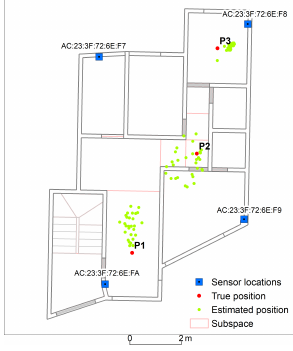
Figure 7. Results obtained in scenario one. 2D without obstacles